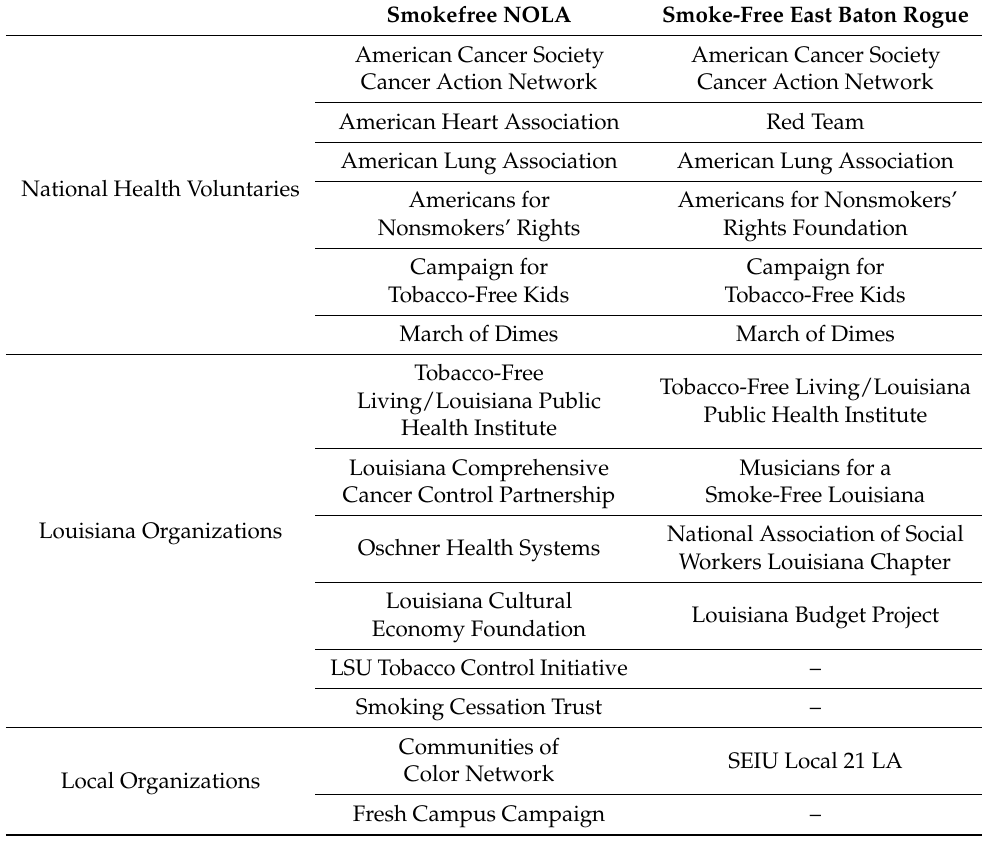
Table 2. Composition of the Smokefree NOLA and Smoke-Free East Baton Rouge Coalitions [27,29,30,32].